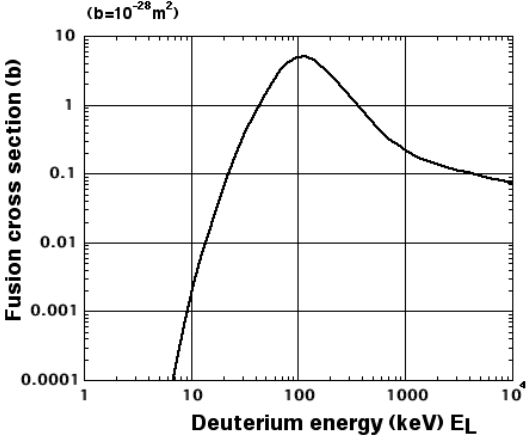
Figure 2. DT Fusion cross section as a function of deuterium energy in laboratory frame E , here  = 23.6 b, E = 2.11 MeV, E = 78.65 keV,  L 0 cL rL barn (10 −28 m 2